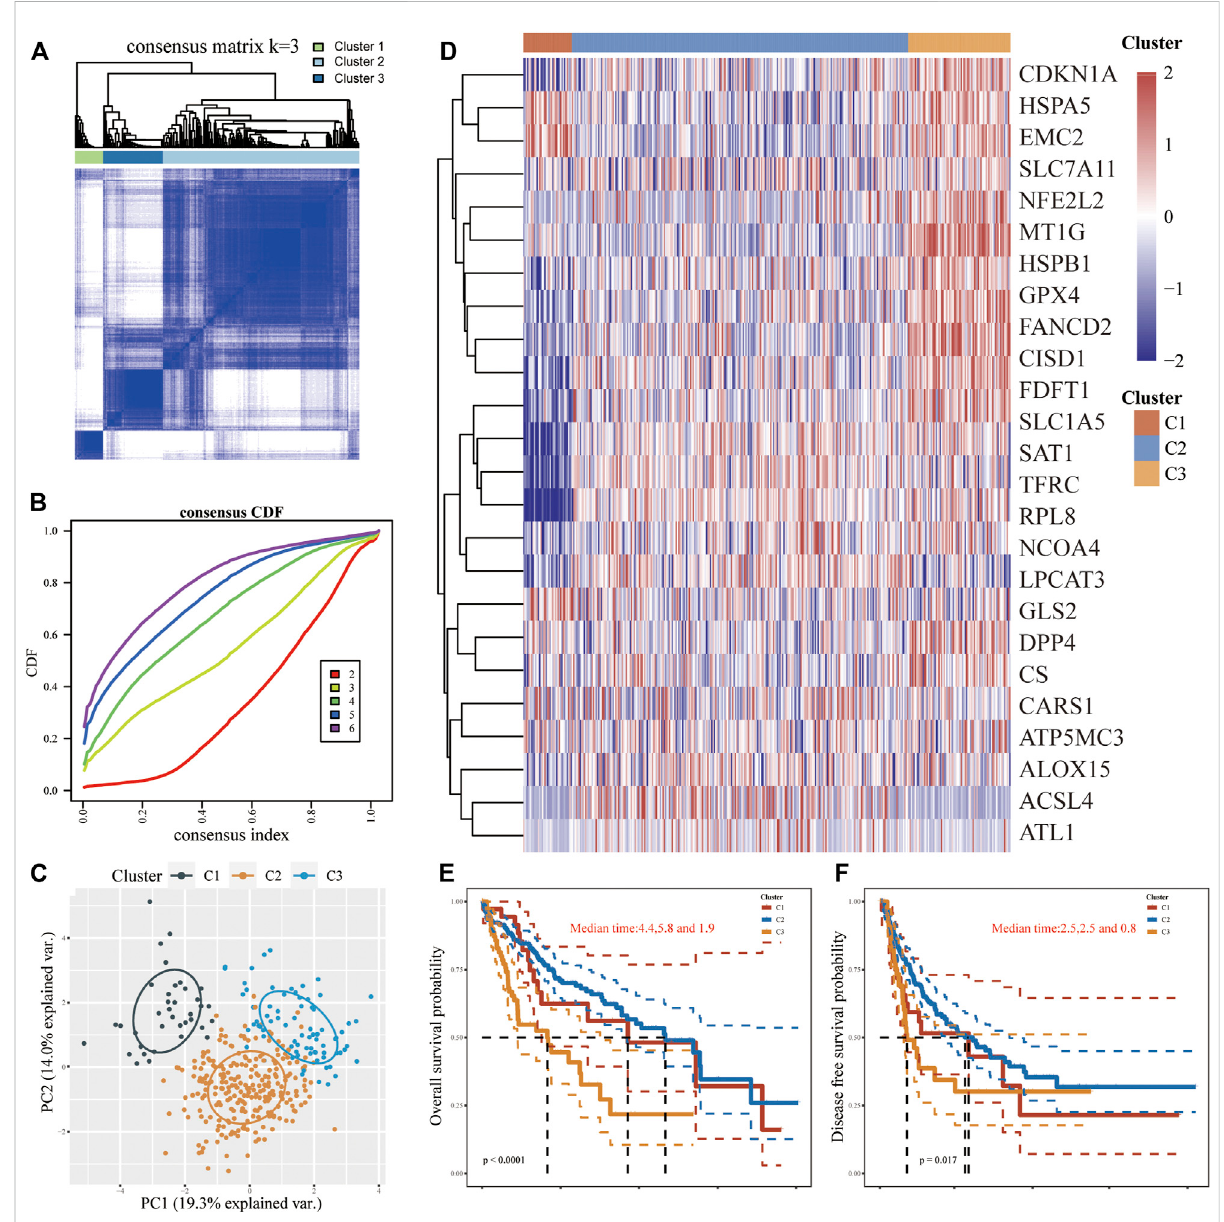
FIGURE 2 FRGs expression levels in different LIHC subtypes and their prognostic patterns. (A,B) Consistent clustering analysis on screening the LIHC subtypes. (C) PCA analysis was performed to clarify the difference in clusters. (D) Heatmap of FRGs expressionlevels in different LIHC subtypes. (E,F) The OS and DFS among three